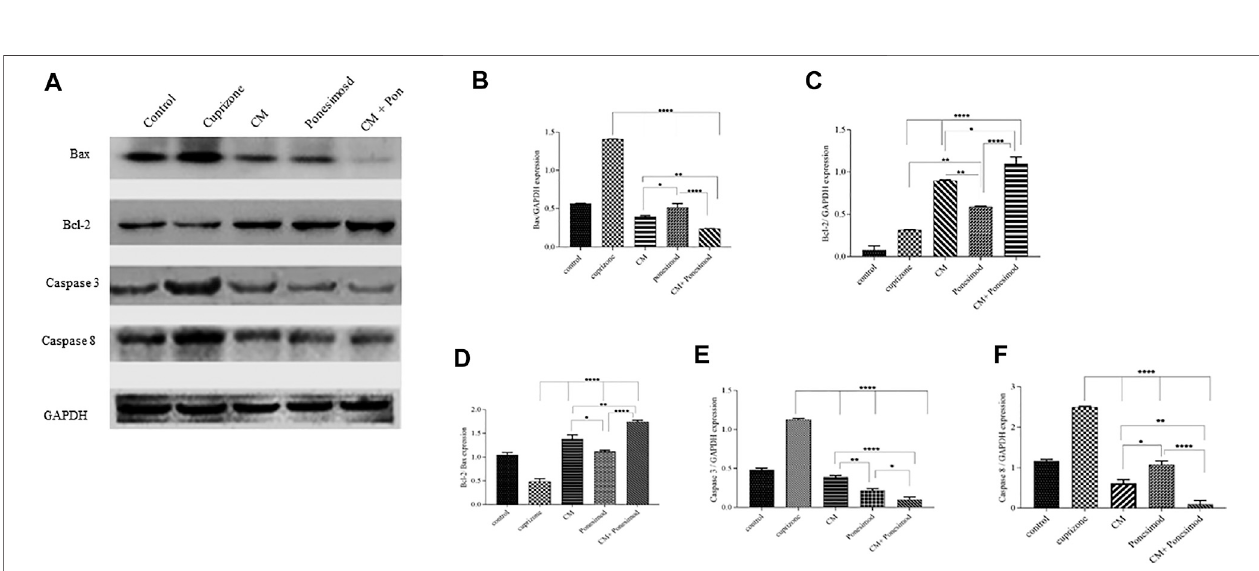
FIGURE 7 | (A) The representative Western blot analysis of the expression of caspase3, caspase 8, BCL-2, and Bax in OLN-93 cells after treatment with CM (30.78 µl), Ponesimod (5.7 nM), and CM + Ponesimod. GAPDH was used as an internal reference (B) Bax/GAPDH expression (C) BCL-2/GAPDH expression (D) A histogram that shows the relative BCL-2/Bax ratio. (E, F) Detection of expressions of Caspases three and eight oligodendrocyte cell line after treatment with CM, Ponesimod, and CM + Ponesimod. GAPDH was used as standard housekeeping marker (* p < 0.05, ** p < 0.01 and **** p < 0.0001).